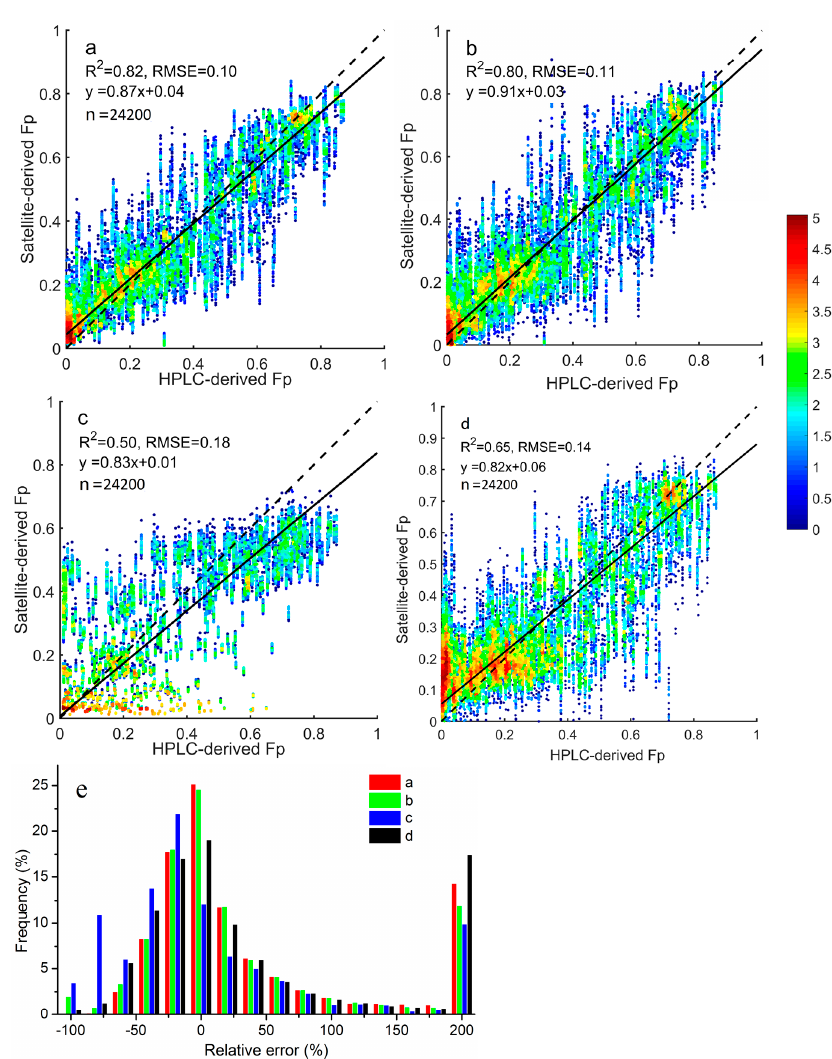
Figure 4. Scatter plots of satellite-derived versus high performance liquid chromatography (HPLC) picoplankton size fractions (Fp): ( a ) random forests using features selected with SVM-RFE, ( b ) SVM using features selected with SVM-RFE, ( c ) SVM using ocean color features selected with SVM-RFE, and ( d ) three-component method. The dash line is 1:1 line, and the solid is regression line. Plot ( e ) shows the frequency distributions of their relative errors, and the numbers along the color ramp indicates the pixel density after log transformation (y =